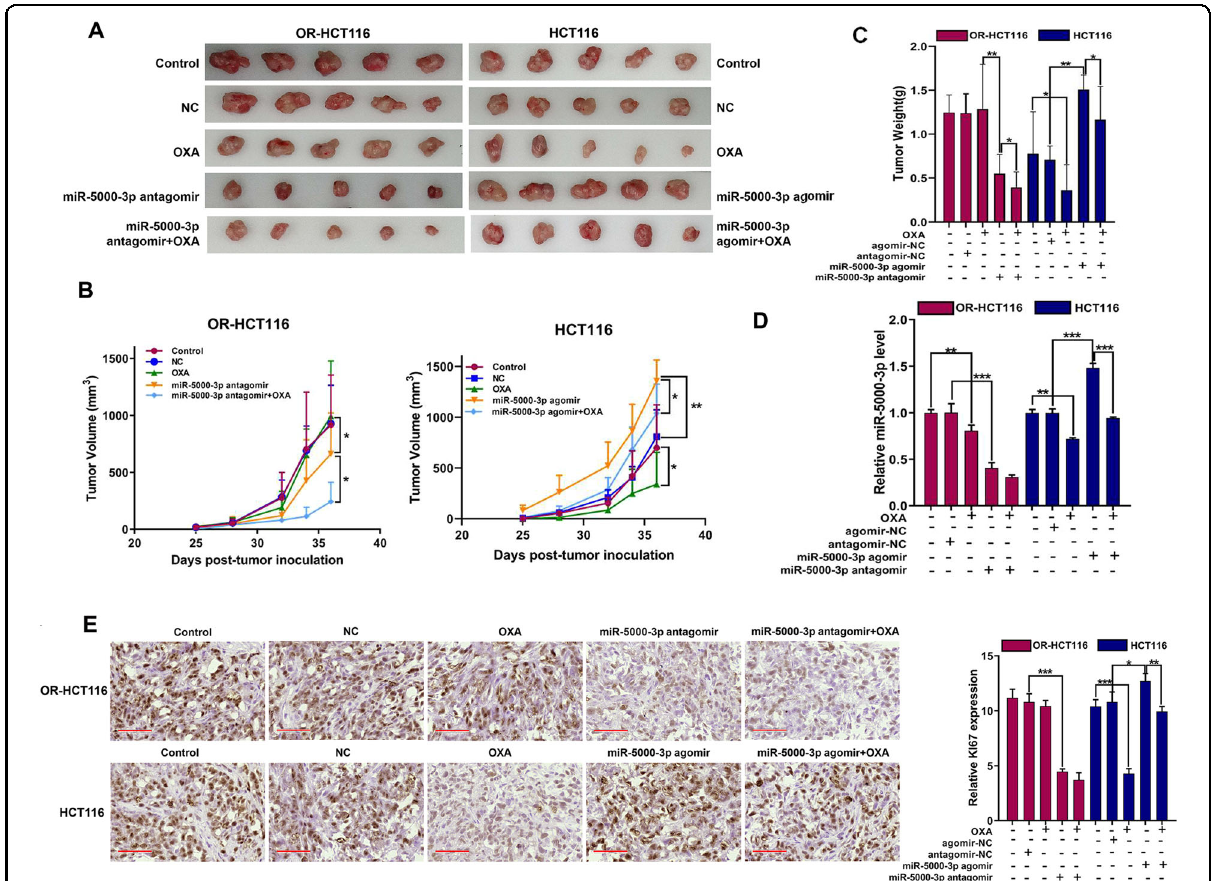
Fig. 4 miR-5000-3p regulates cell proliferation and tumor growth. A – C HCT116 and OR-HCT116 cells were subcutaneously injected into nude mice. Tumor volumes ( B ) were measured at indicated days. Mice were sacri fi ced after 5 weeks. Tumor images were acquired as shown in ( A ) and tumor weights were measured as shown in ( C ). n = 5. D The mRNAs were extracted from the cells for miR-5000-3p detection and subjected to